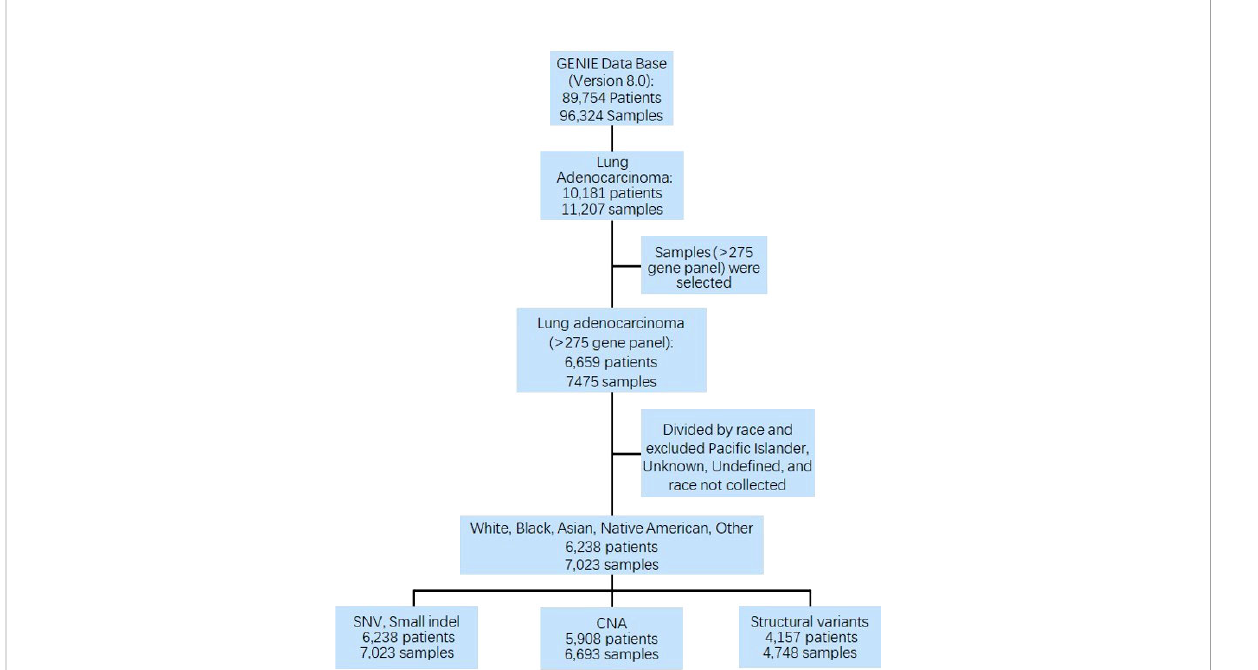
FIGURE 1 CONSORT diagram detailing the study cohort. GENIE, Genomics Evidence Neoplasia Information Exchange; SNV, single nucleotide variant; CNA, copy number